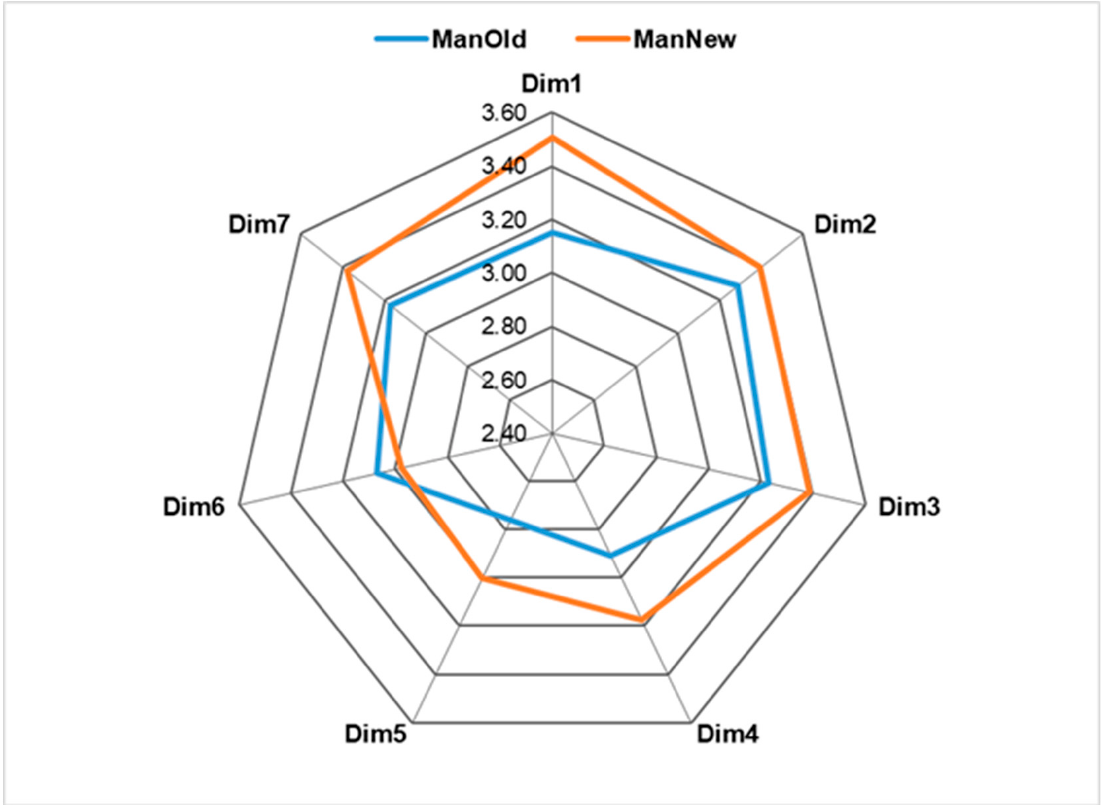
Figure 6. Results of the responses of managers to NOSACQ-50 in the current study (ManNew) compared to those of previous research [8] (ManOld).